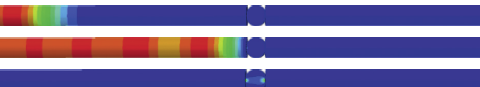
Figure 12: Three stages of the dynamic splitting process.